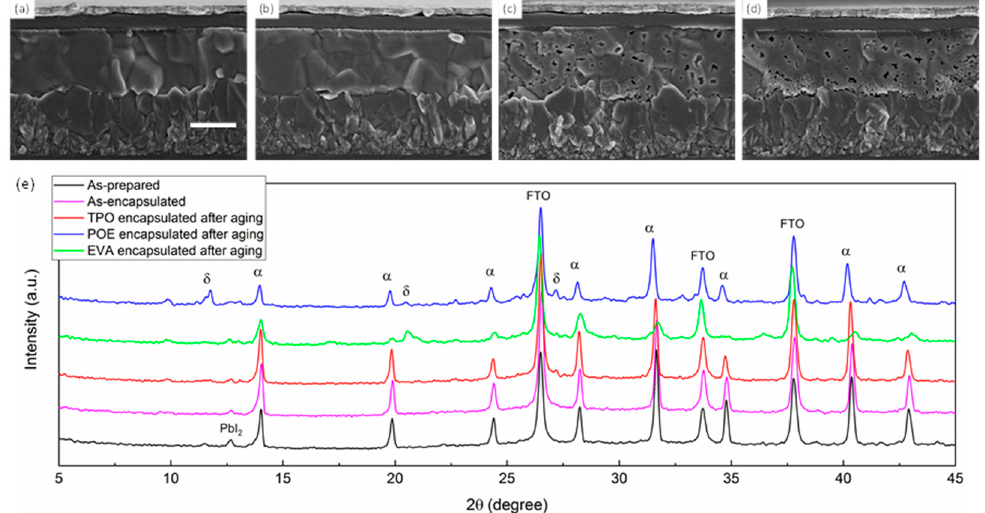
Figure 4. SEM images of ( a ) as-prepared PSC and encapsulated PSC with ( b ) TPO, ( c ) POE, and ( d ) EVA after aging. The scale bar is 500 nm. ( e ) XRD patterns of perovskite films on FTO substrates encapsulated with different materials before and after aging.